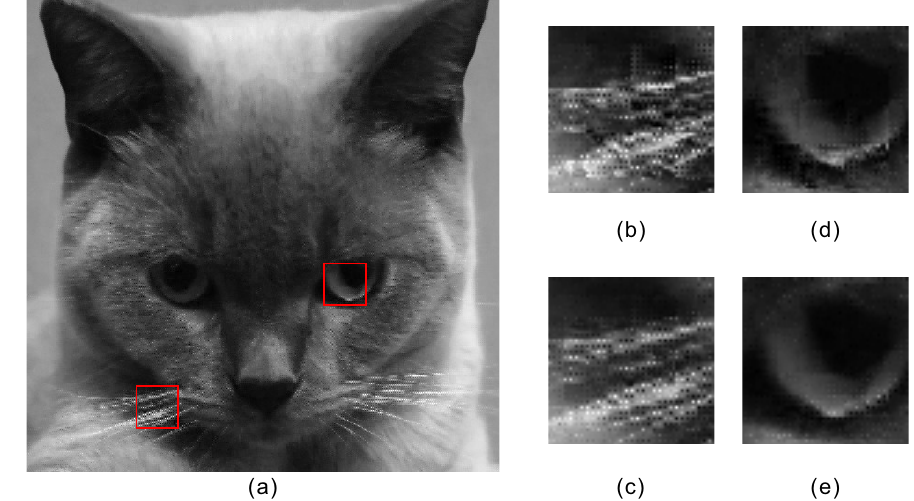
Figure 10. A 2 × interpolated Cat image by mean filtering a set of four cyclic spin fractal decoding images (original plus 3 other shifted images) with doubled range block size (i.e., 16 × 16) and interleaved low-resolution image pixels using fractal interpolation method with interleaving (PSNR = 27.39 dB, SSIM = 0.887): ( a ) the full interpolated image; ( b ) zoom-in portion of the whiskers of the Cat image obtained from fractal interpolation method with interleaving but nomean filtering (same as Figure 8f), and ( c ) from mean filtering shifted fractal decoded images; ( d ) zoom-in portion of the eye of the Cat image obtained from a fractal interpolation method with interleaving but no mean filtering (the same as Figure 8g), and ( e ) from mean filtering shifted fractal decoded